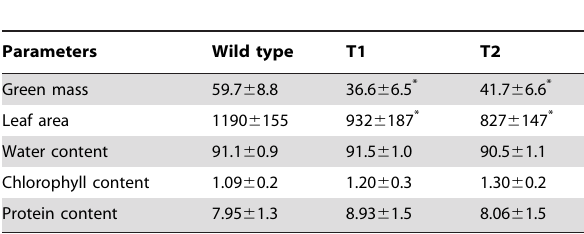
Table 1. Measured parameters, as indicated, of potato plants grown under optimal